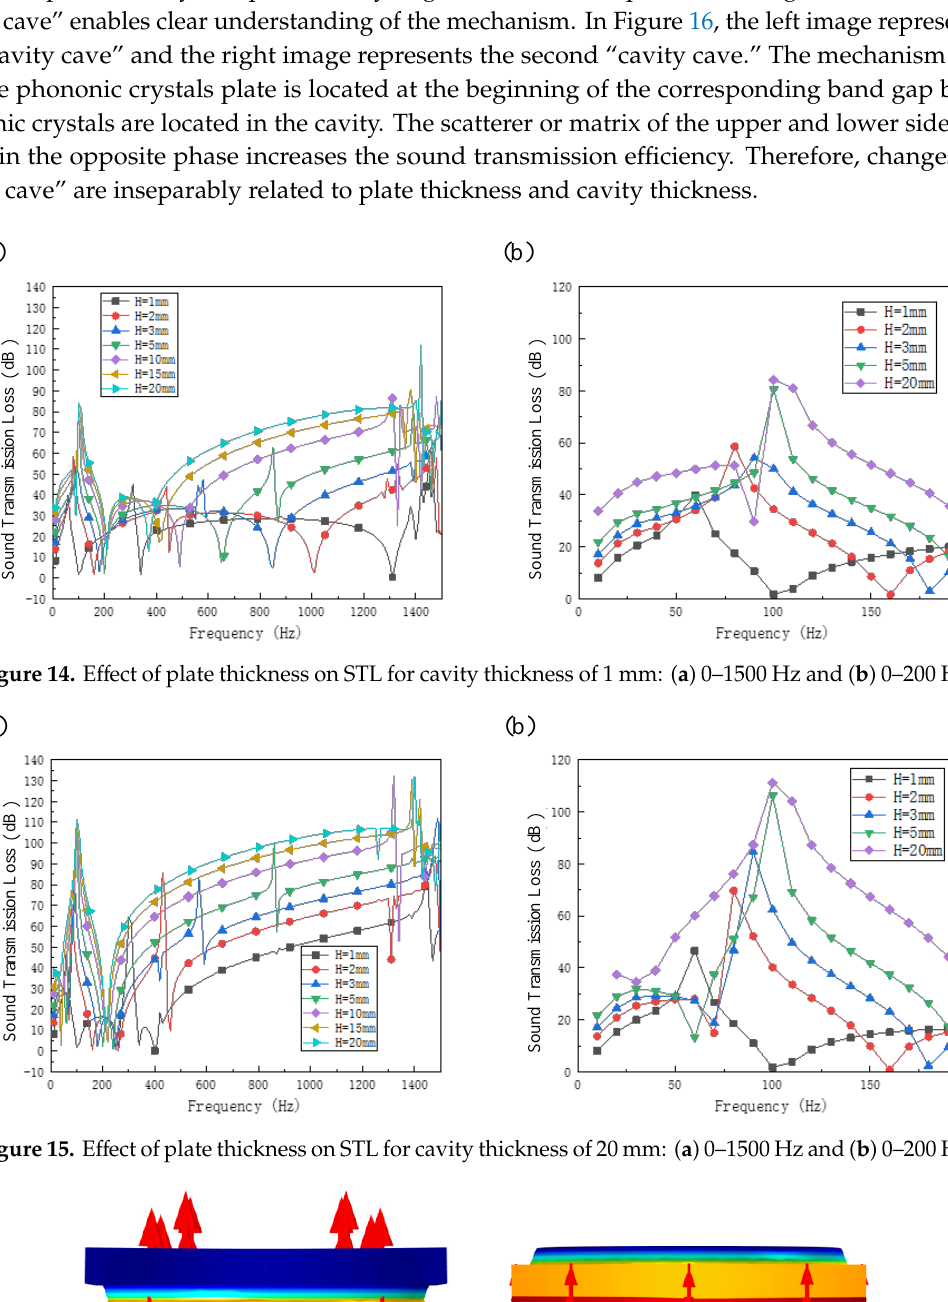
Figure 16. Vibration displacement diagram of ”cavity cave” end point.